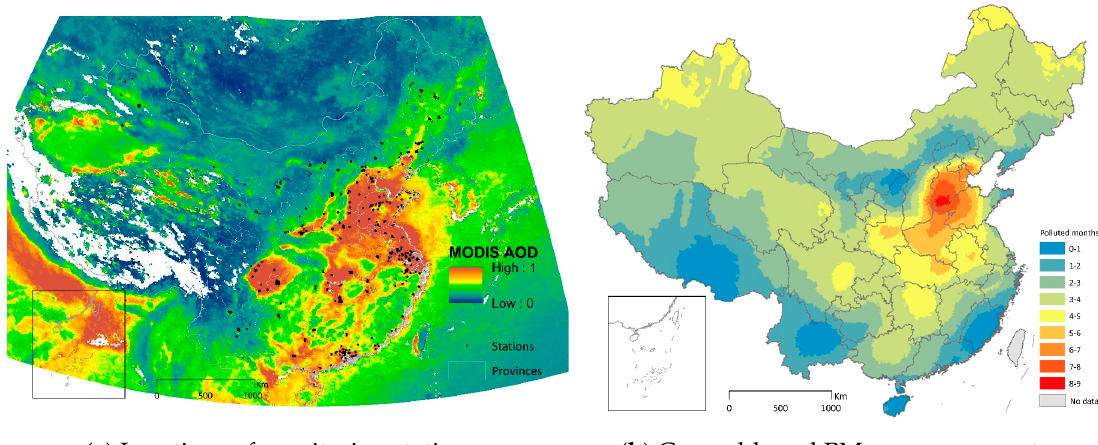
Figure 1. Panel ( a ): spatial distribution of monitoring stations in 190 Chinese cities and Moderate Resolution Imaging Spectroradiometer (MODIS) Aerosol Optical Depth (AOD) at 550 nm average from 8 April 2013 to 7 April 2014 as the background of this panel. By the end of 2013, 945 stations have disclosed PM 2.5 concentrations to the public. Panel ( b ): the duration of PM 2.5 above China’s daily standard spatially interpolated by ground-based observations only. We convert the number of pollution days to months by assuming 30 days in a month.